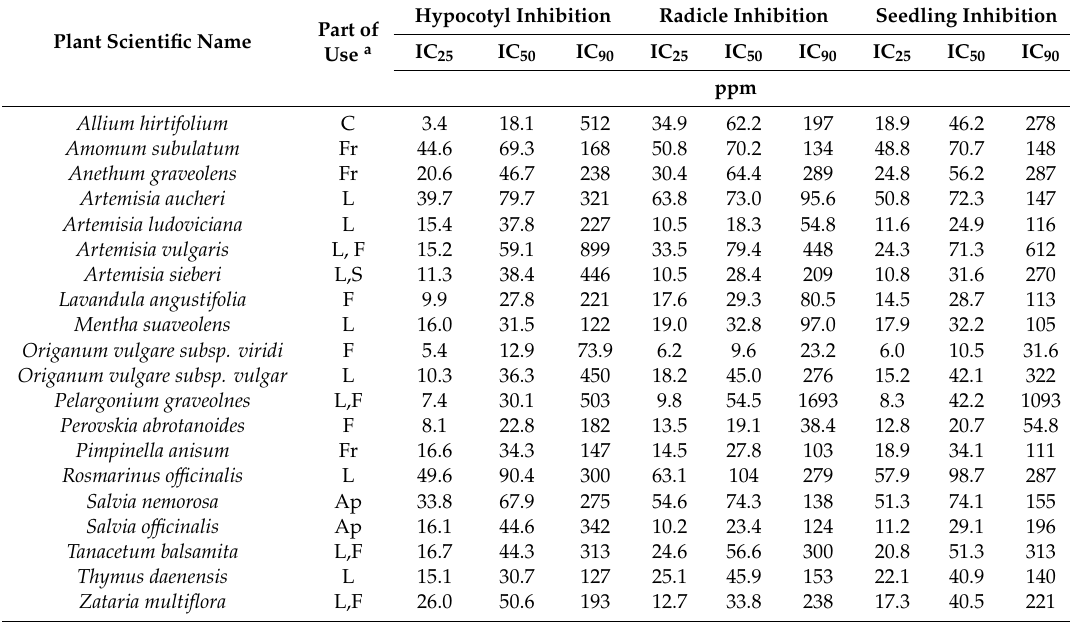
Table 4. The e ff ective concentration of EOs on radicle, hypocotyl, and seedling inhibition by cotton swab